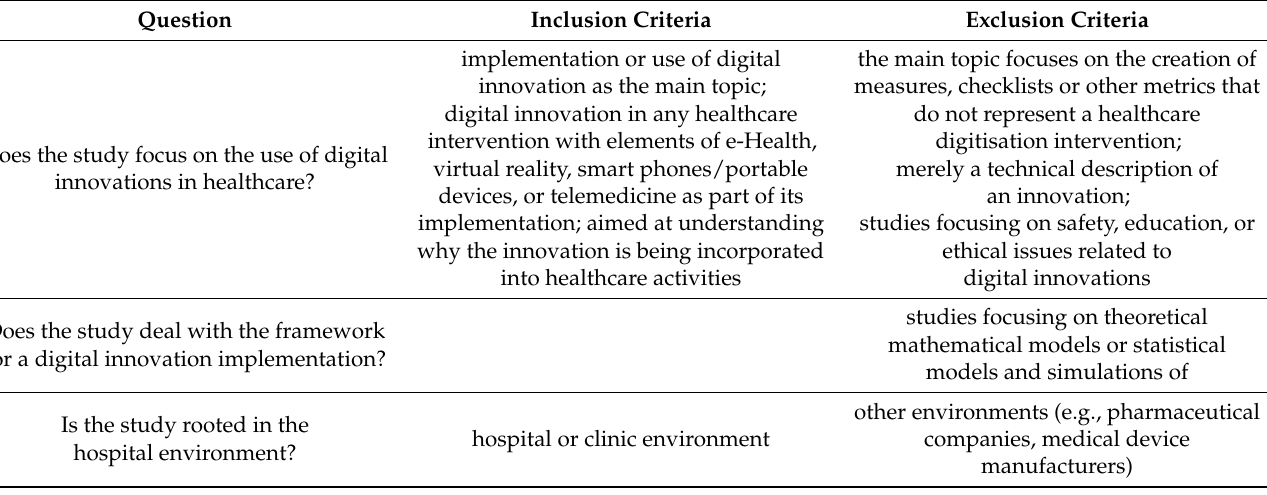
Table 5. Inclusion and exclusion criteria used in the systematic literature